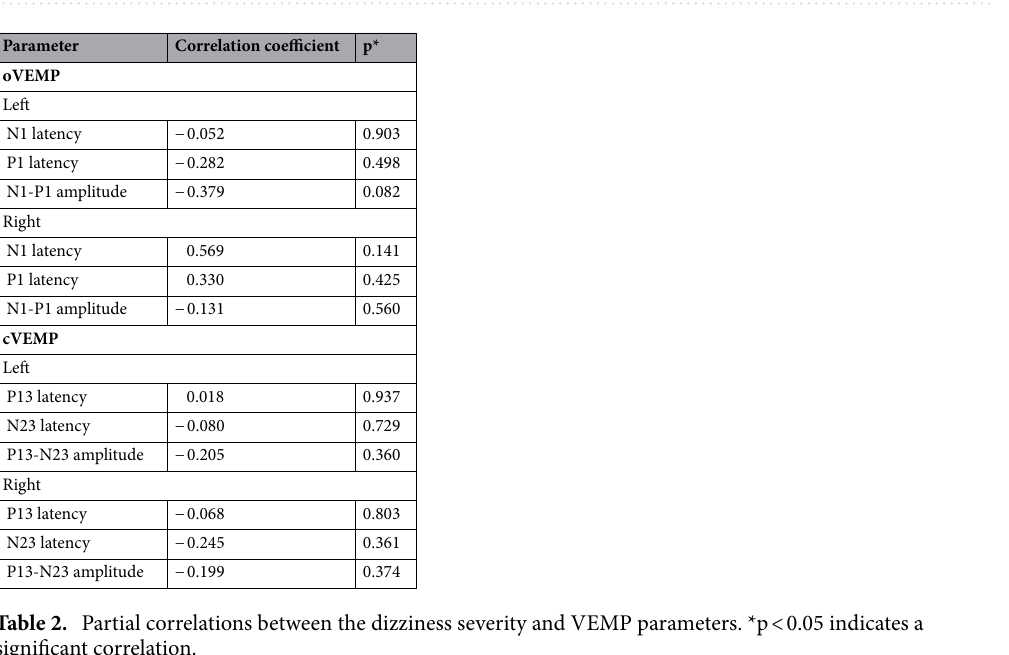
Figure 2. The comparison of bilateral absent, unilateral absent, and present VEMP responses between PD patients with and without dizziness. ( A ) oVEMPs. ( B ) cVEMPs.